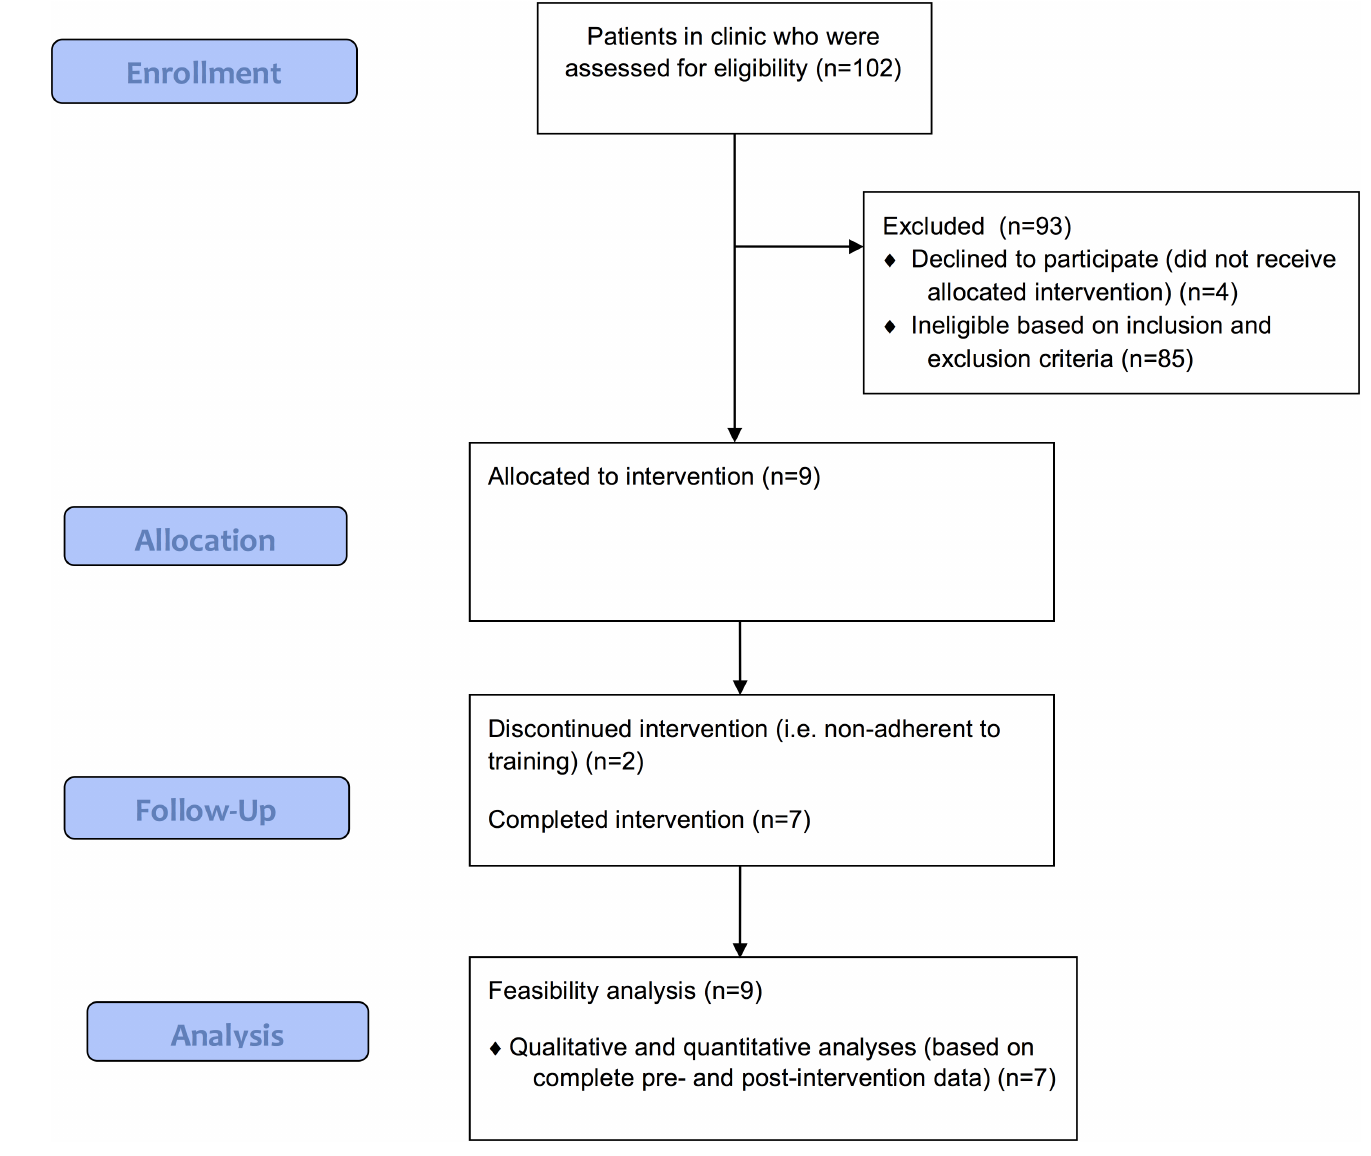
Fig 1. Flowchart of participant enrollment, inclusion, and